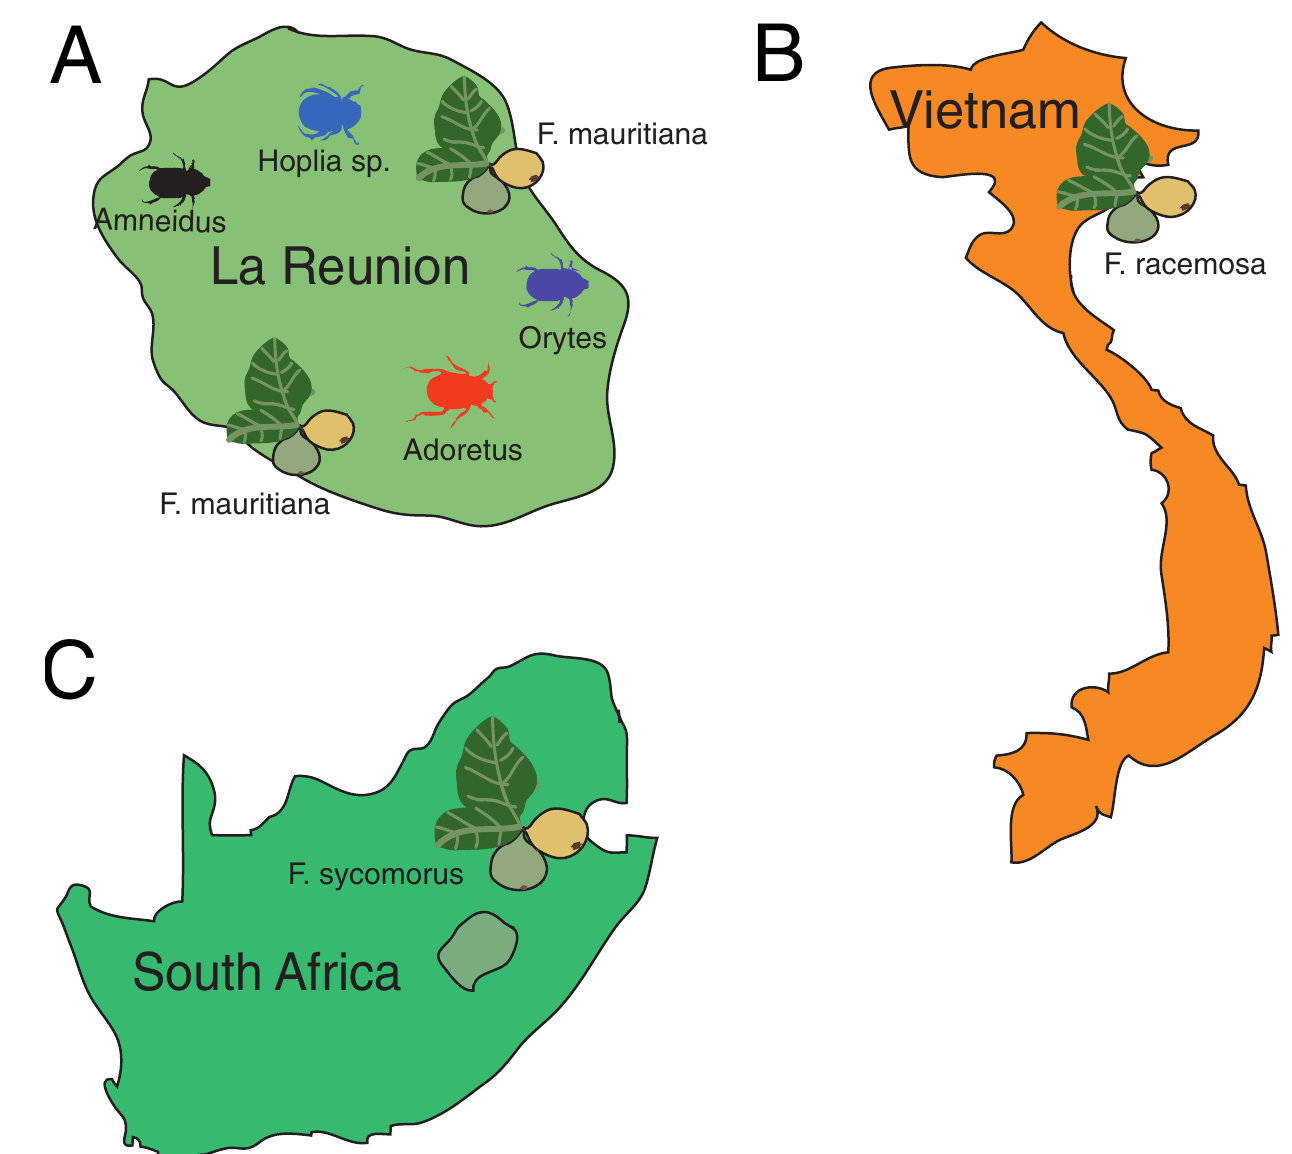
Fig 1. Regional maps of beetle and fig sampling sites. (A) Map of La Re´union Island showing the approximate beetle and fig sampling sites. O . borbonicus , Adoretus sp., Hoplia sp . and A . godefroyi beetles were collected to isolate Pristionchus -associated bacteria. Similarly, F . mauritiana figs were sampled and processed for bacteria isolation. (B) and (C) F . sycomorus (Brummeria, Pretoria, South Africa) and F . racemosa (Hanoi, Vietnam) figs were dissected under sterile conditions from Pristionchus -positive specimens to isolate bacteria.